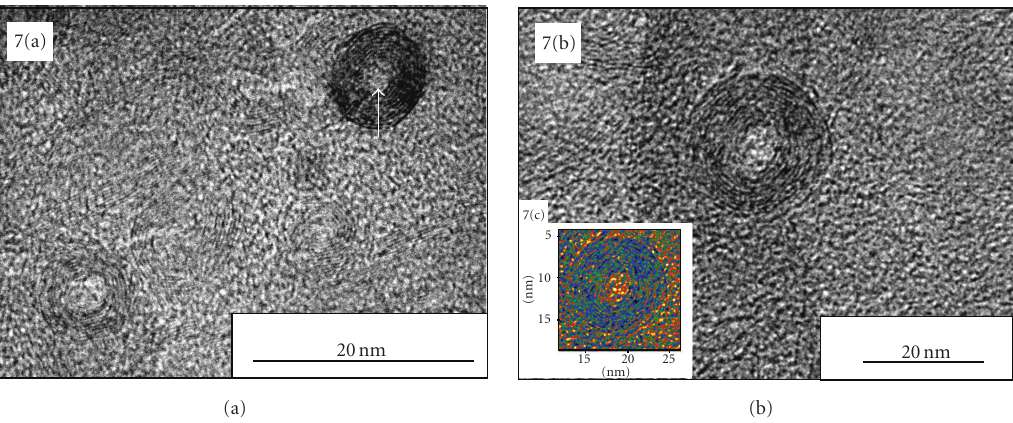
Figure 7: TEM micrographs of cured epoxy nanocomposites (a, b) and image analysis of frequency distributions (c).